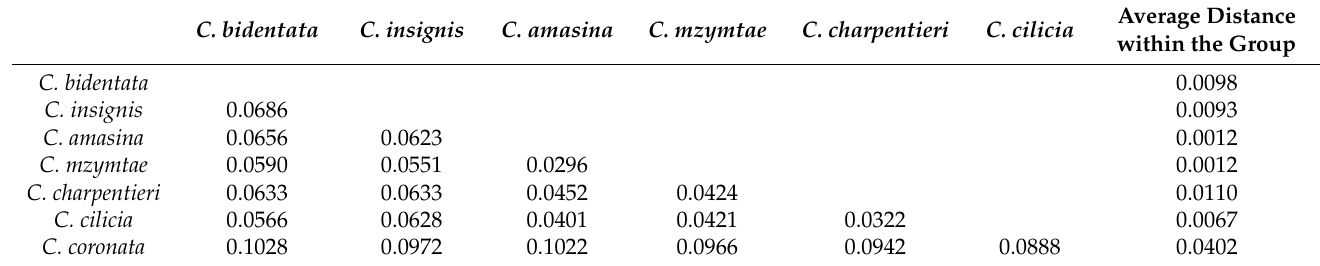
Table 4. Genetic distance, estimated by the Kimura 2-parameter method, between the different species in the Cordulegaster bidentata -group and C. coronata